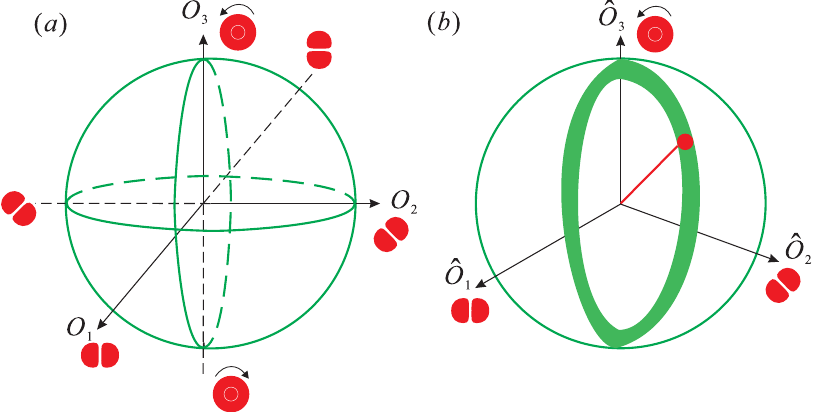
Figure 1. ( a ) Orbital Poincaré sphere for the first-order spatial modes. ( b ) Quantum noise representation of OAM state (thick ring) on the Poincaré